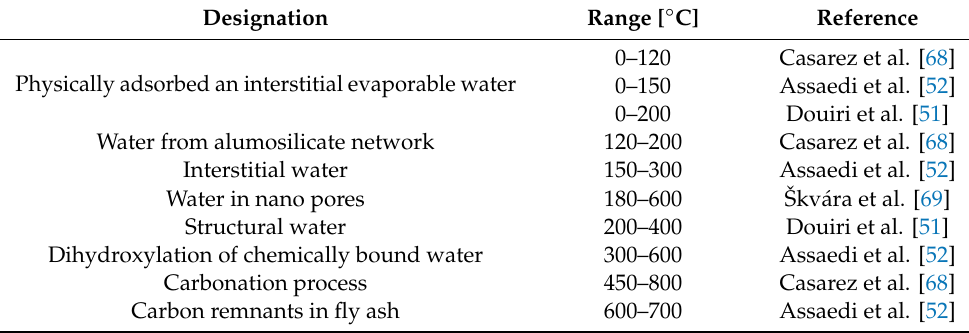
Table 5. Temperature ranges and designation of the associated mass loss taken from